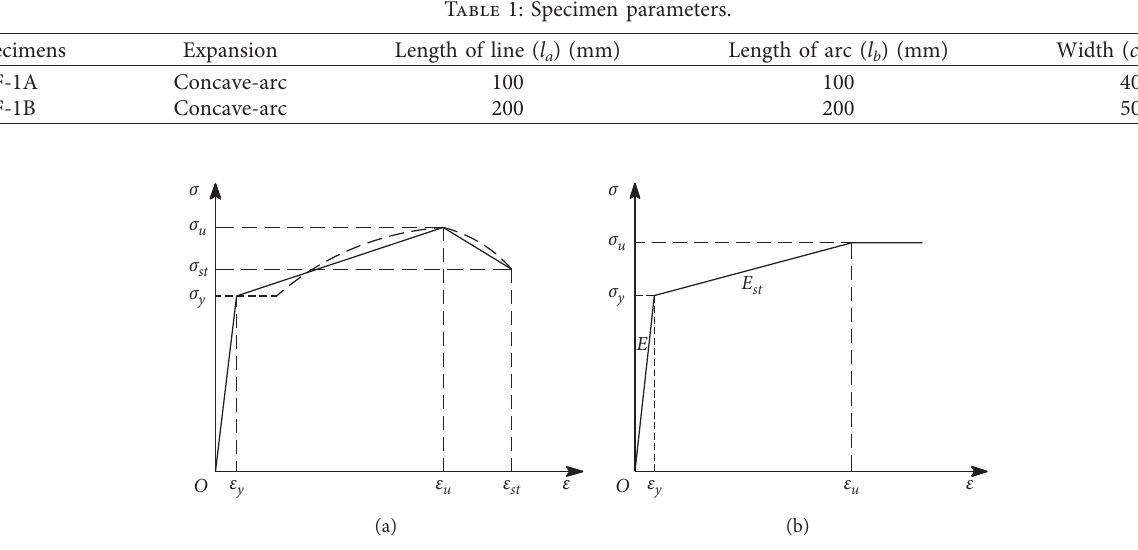
Figure 2: Material constitutive model. (a) Q235B steel. (b) E4315 weld.